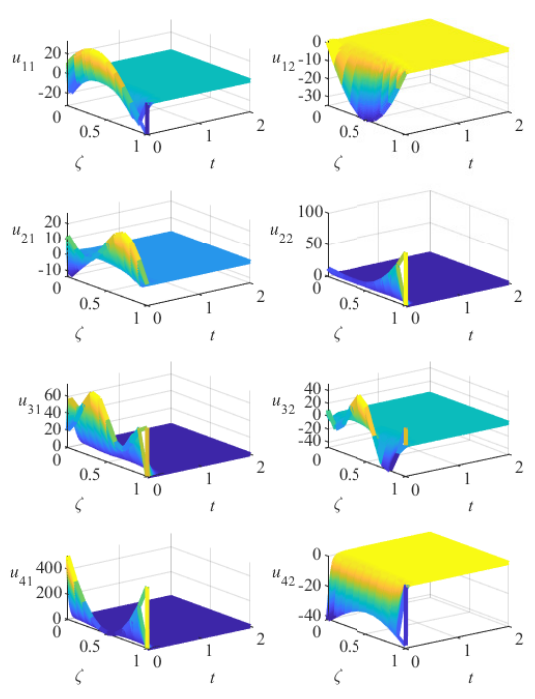
Figure 6. The control input of HPDECSTN